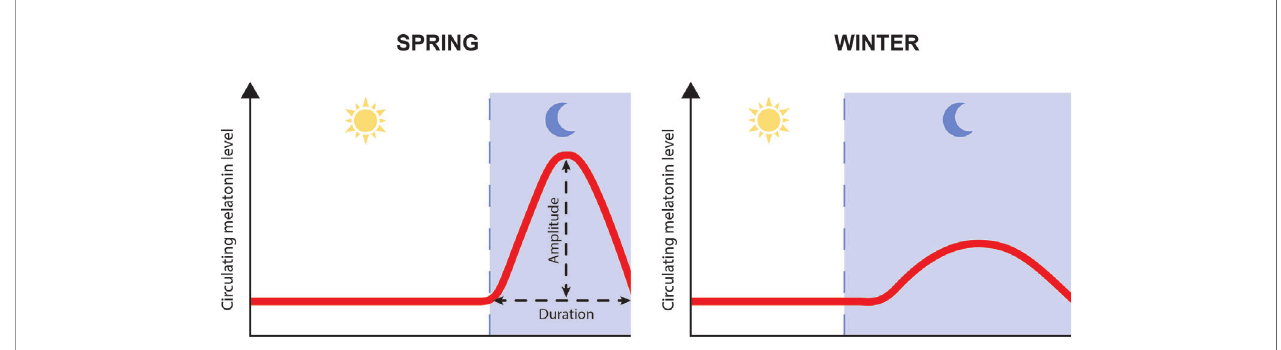
FIGURE 1 | Schematic representation of daily and seasonal fl uctuation in plasma